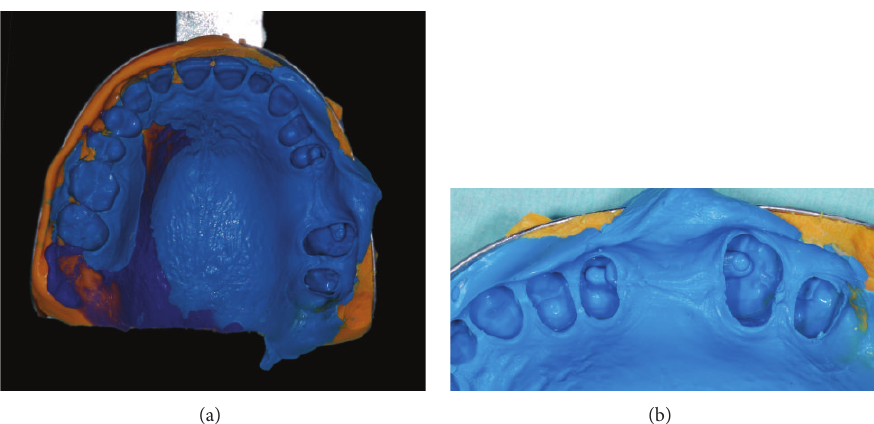
Figure 3: (a) Occlusal view of the final elastomeric impression. (b) Close-up of silicon impression; light body material reproduced every preparation fine details.